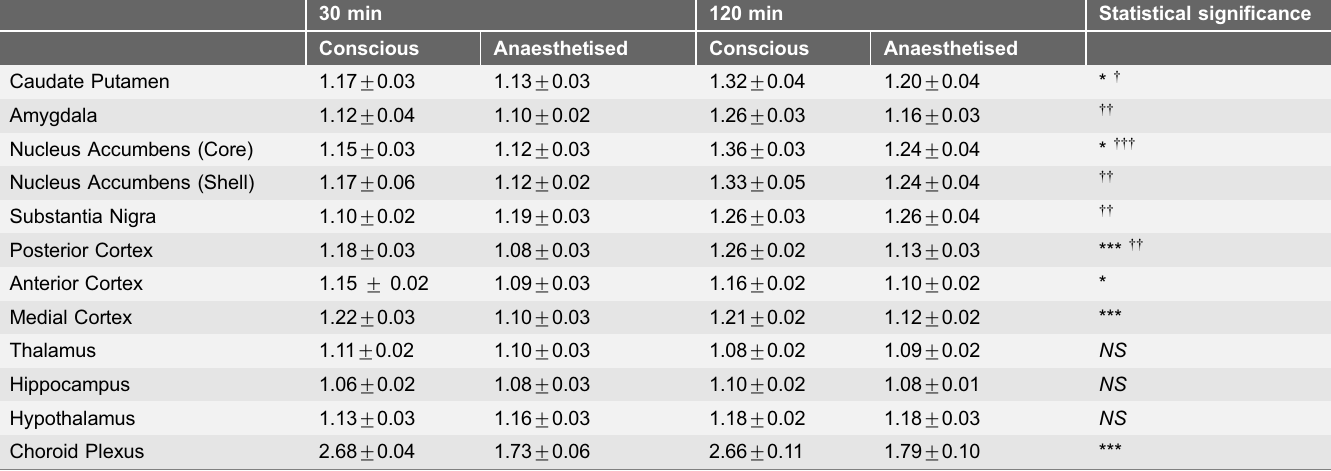
Table 1. Target to cerebellum ratios in discrete regions of the rat brain following administration of [ 125 I]WYE-230949 (n 5 4 to 5 for all groups) determined by ex vivo autoradiography. 30